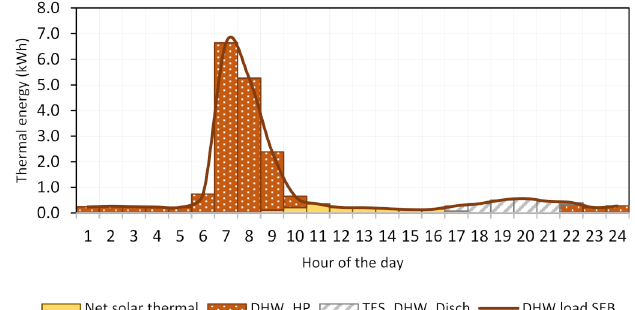
Figure 22. Thermal energy balance of the SEB for domestic hot water obtained with stochastic economic optimization for the representative winter day.